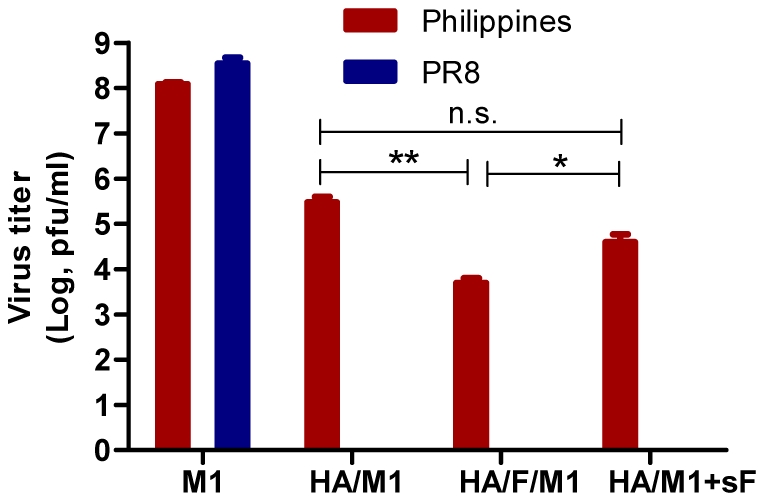
Lung viral loads on day 4 post-challenge infection with the homologous virus A/PR8 or the heterosubtypic virus A/Philippines.Mice immunized IN with designed doses of VLPs were challenged with a lethal dose (40 LD50) of A/PR8 or A/Philippines. Six mice were included in each viral challenge group. Four days after infection, mouse lungs were collected and extracted with medium RPMI 1640. The extract was adjusted to 1 ml per lung. Virus titers in lung extracts were titrated using MDCK-based plaque assay as described in Materials and Methods. The lung virus titer is presented as pfu per lung.